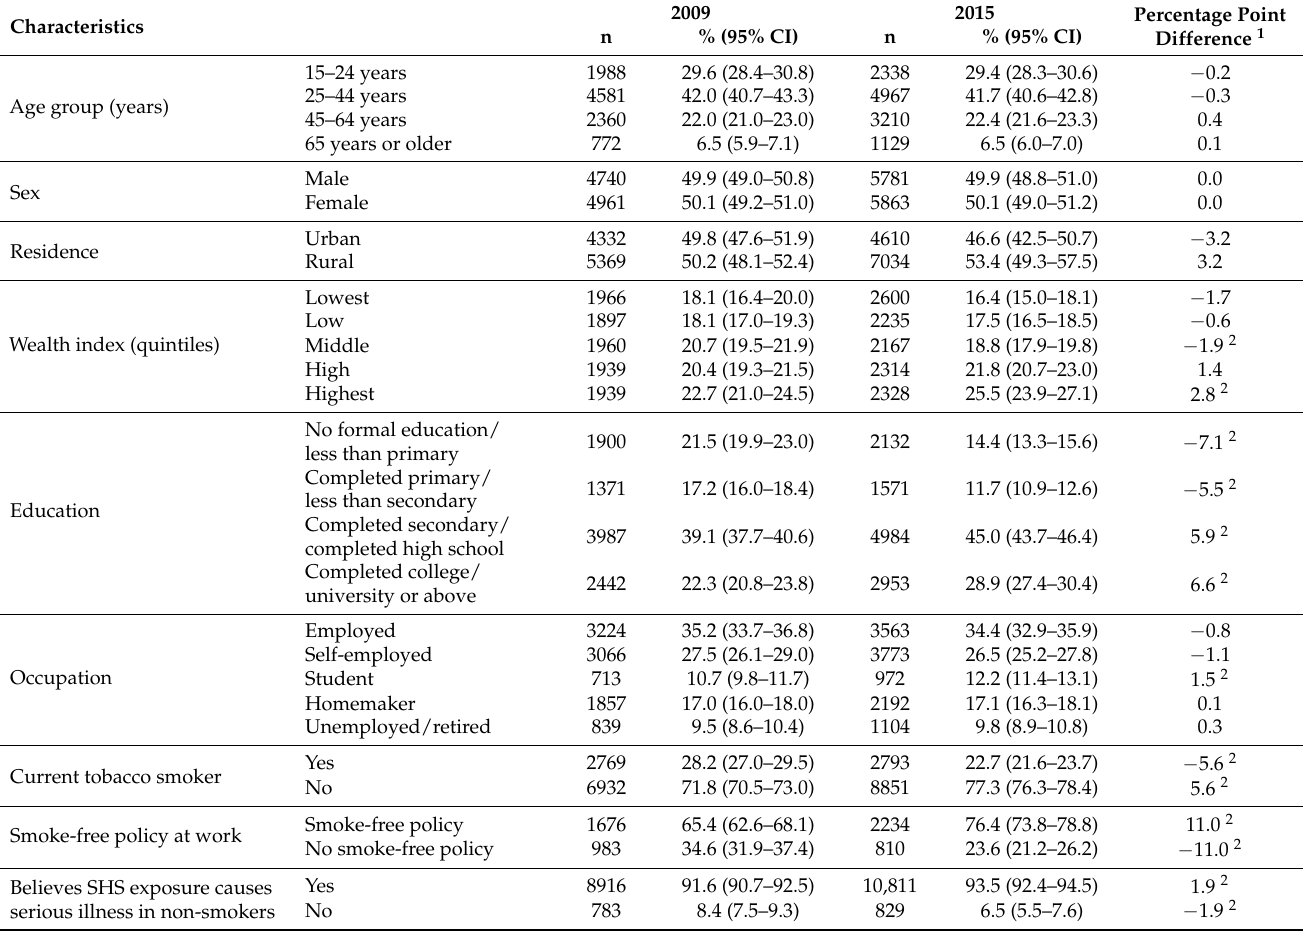
Table 1. Sociodemographic characteristics, tobacco use, and SHS policies among adults aged 15 years or older in the Philippines, 2009 and